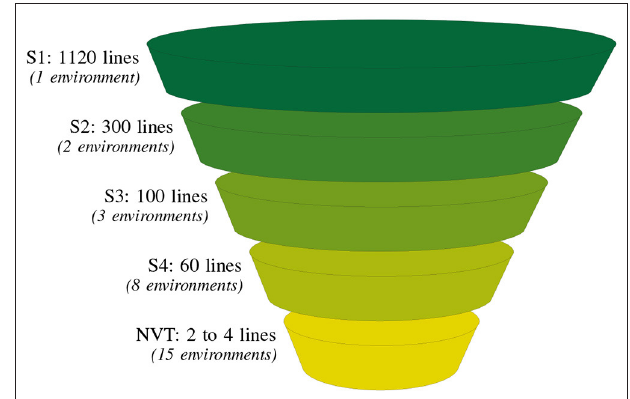
FIGURE 1 | Summary of the typical number of lines and environments (in parentheses) at each testing stage for one of our motivating examples, the durum breeding program. There are four breeding stages of testing: stage 1 (S1) to stage 4 (S4) and a final stage corresponding to the independent Australian testing system, the National Variety Trials